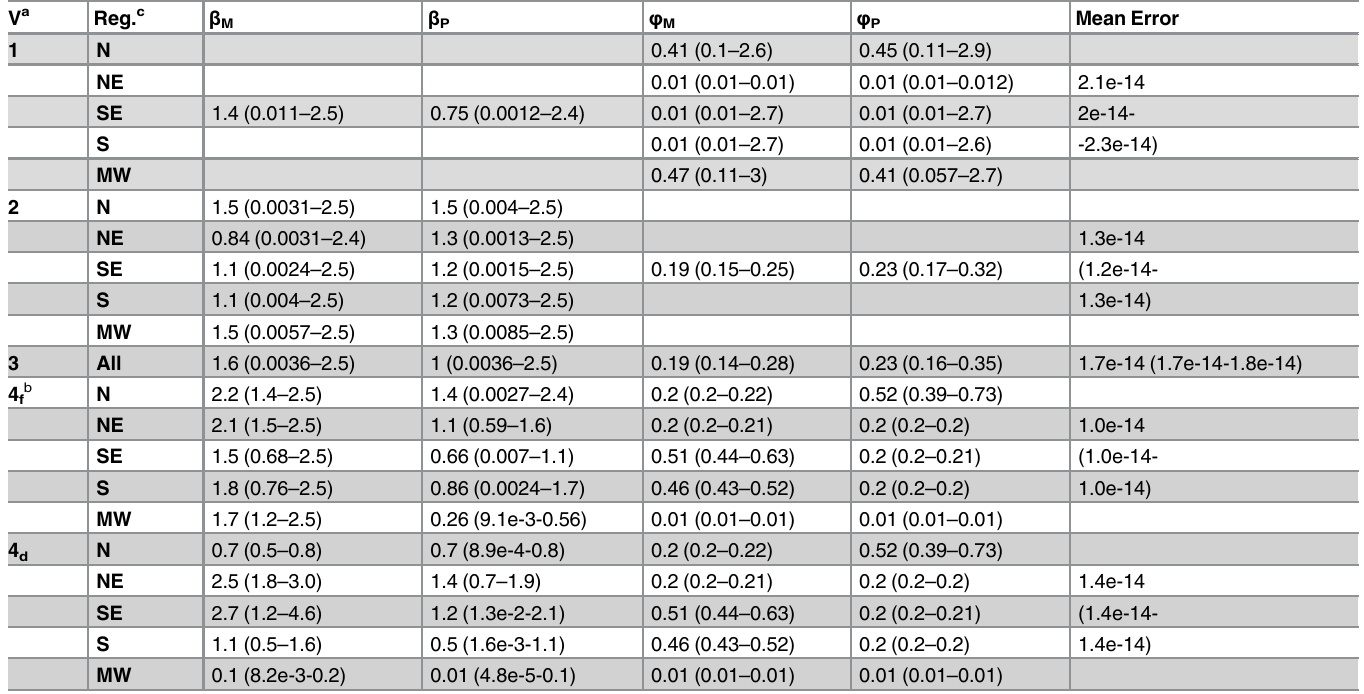
Table 2. Posterior distribution median and 95% prediction intervals determined by ABC fitting of Approximate Bayesian Computation models for Hansen ’ s Disease to data from the 5 regions of Brazil. Version 4 consisted of fitting the regional best-fit model to each region ’ s observed data separately with both frequency and density-dependent transmission assumptions; all other versions used a hierarchical structure with density-dependent transmission in which at least some parameters were shared across regions, and fitting was done simultaneously across all 5 regions. Mean error refers to the average value of d per iteration of each version, based on a sample of 1,000 iterations, with confidence intervals based on 100 samples of 100 iterations